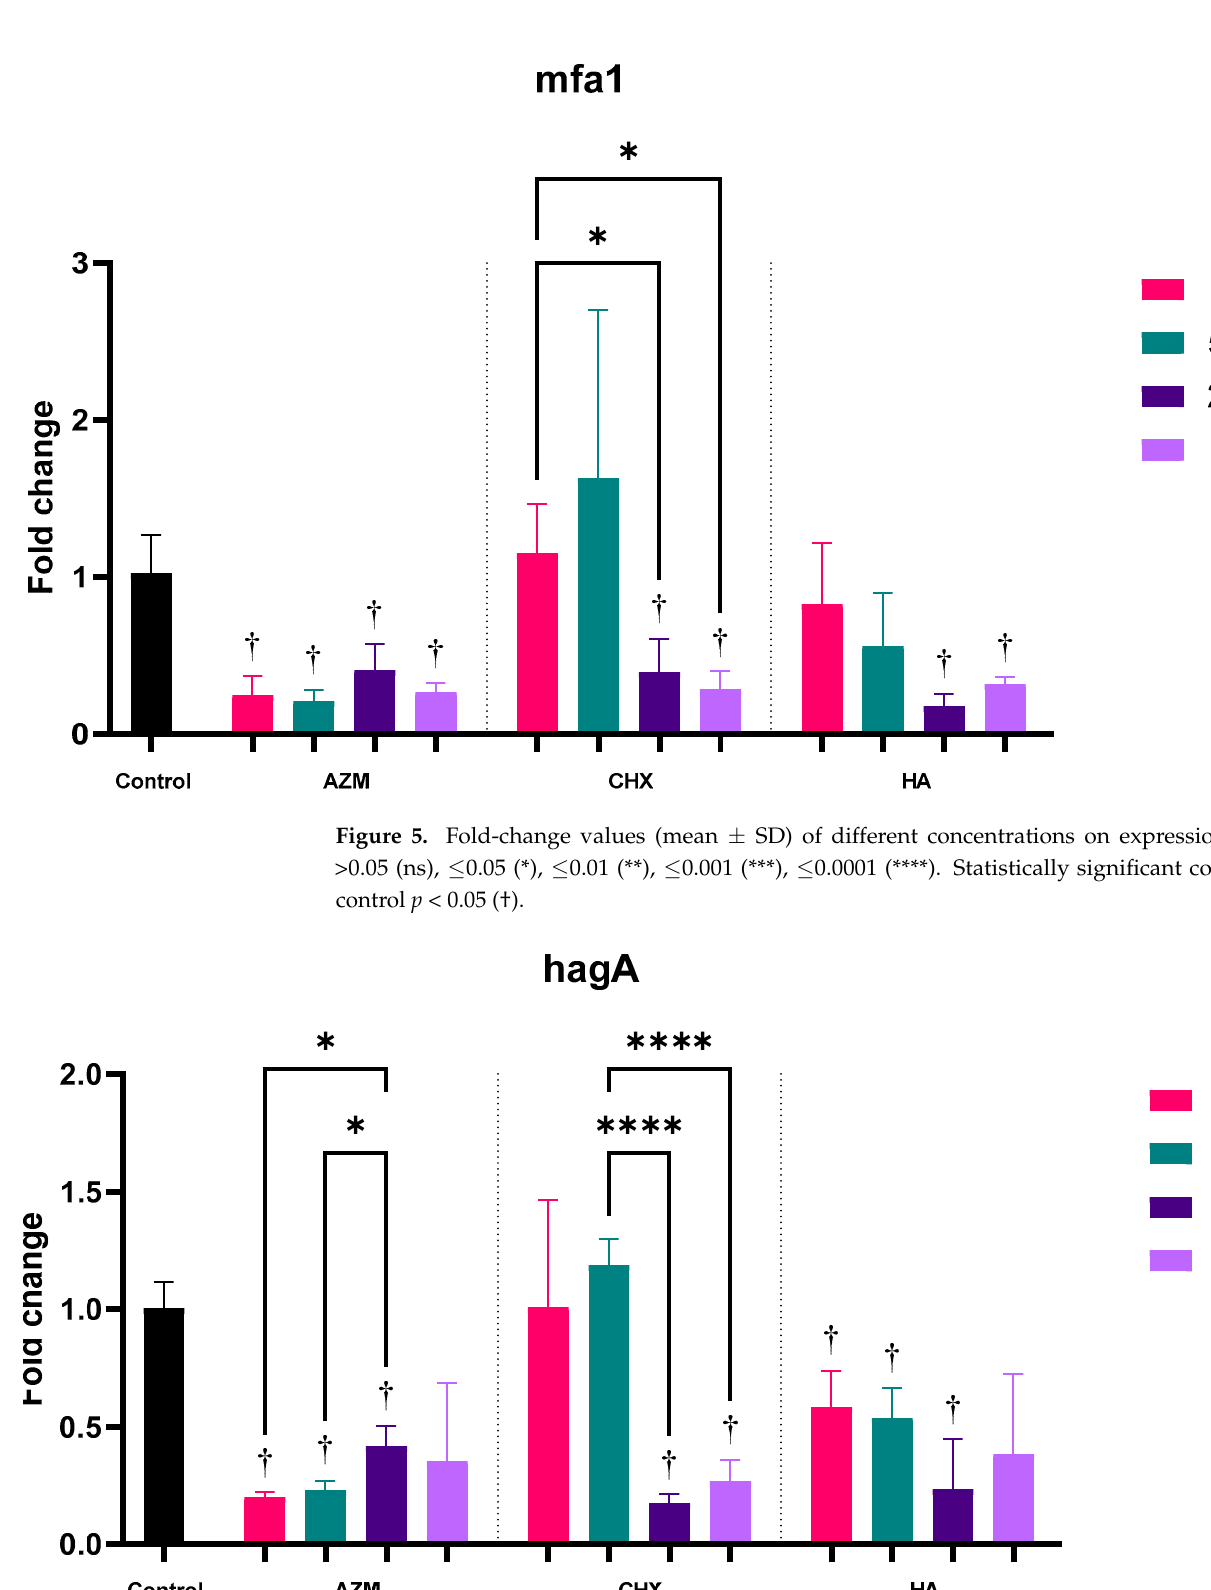
Figure 6. Fold-change values (mean ± SD) of different concentrations on expression of hagA. >0.05 (ns), ≤ 0.05 (*), ≤ 0.01 (**), ≤ 0.001 (***), ≤ 0.0001 (****). Statistically significant compared to control p < 0.05